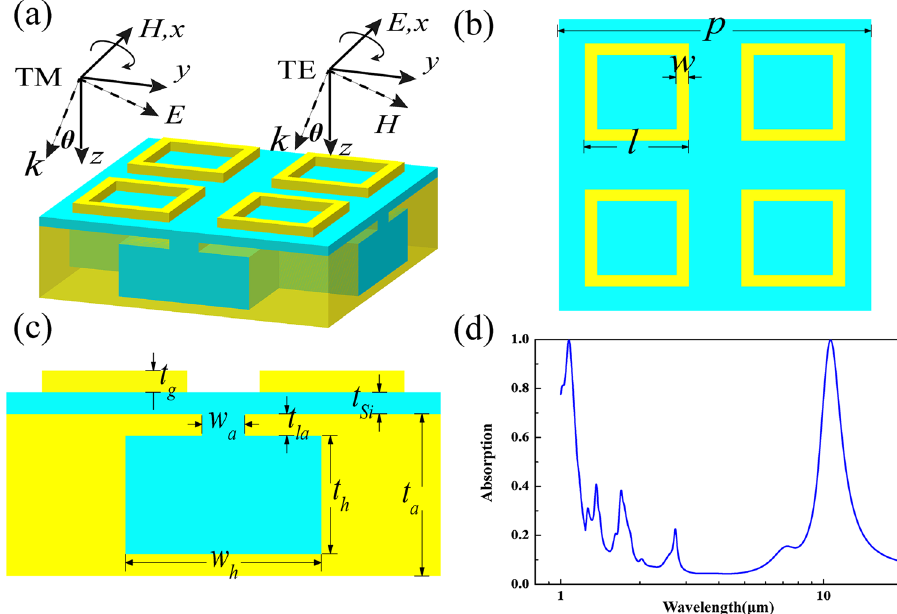
Figure 1. Geometrical model of the proposed dual-band perfect absorber. ( a ) 3D view. ( b ) Top view. ( c ) Side view. ( d ) Absorption spectrum of the designed absorber under normal